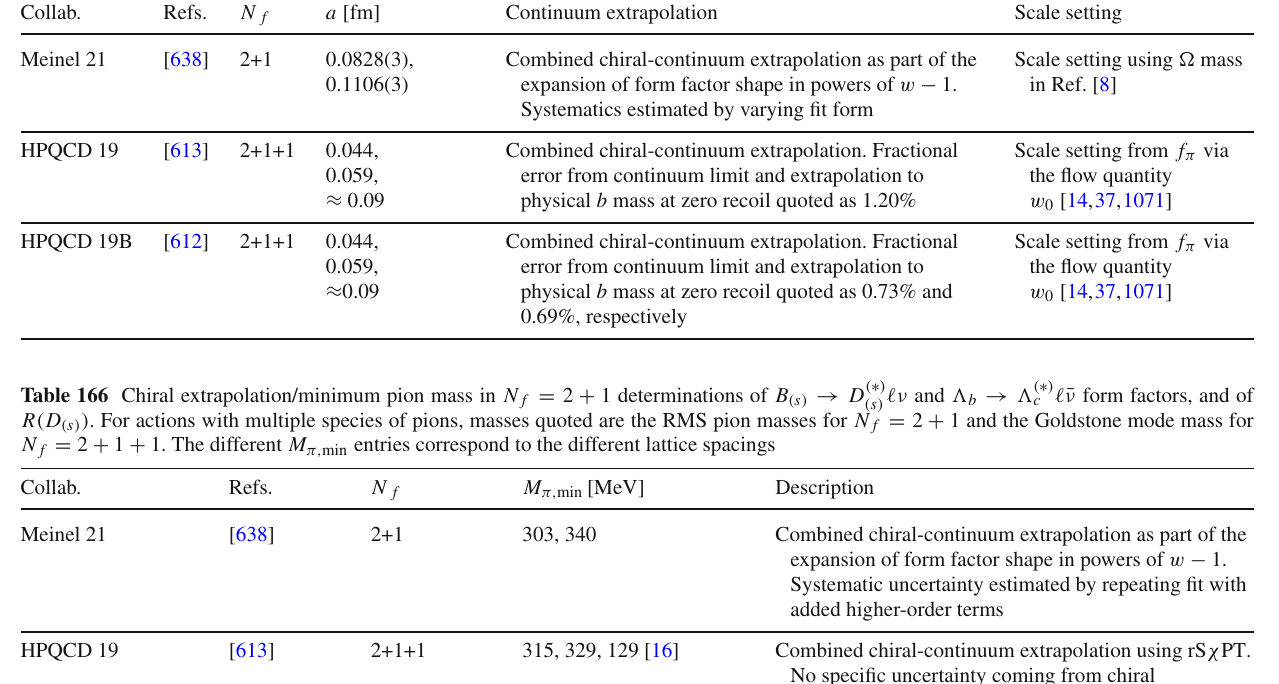
Table 165 Continuum extrapolations/estimation of lattice artifacts in N f = 2 + 1 determinations of B ( s ) → D ( ∗ ) ( factors, and of R ( D ( s ) ) Collab.